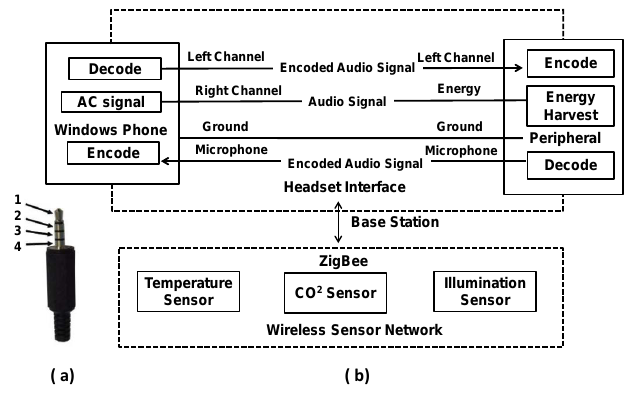
Figure 4: (a): The headset plug and pinout: (1) left earphone (tip), (2) right earphone (ring), (3) common/ground (ring), (4) microphone (sleev e). (b): The structure of Hijack system. It is a big challeng e to obtain energy from the headset port and convert it with high conversion e ffi ciency [19]. The headset outputs a low voltage signal, which is even lower than the typical transistor’ s threshol d voltage. So it is necessary to use energy harv esting circuit to convert it to a higher voltage signal. In Hijack, the energy harv esting circuit consists of a step- up micro- transf ormer, a FET-based rectific tion, some (par allel) blocking Schottky diodes and some fi ter capacitors [20]. The key design, the micro- transf ormer, lev erages a recen tly introd uced device for f y backing and step-up in energy harv esting applica tions. With this design, the energy harv ester can suppl y 7.4 mW voltage and the transf er scheme o ff ers 8.82 kb bandwid th, which satisfie the interf ace in iPhone. The other engineering challeng e is to provide bi- directional comm unica tion betw een the mobile phone and the microcon troller [21]. To achiev e this goal, the microcon troller needs to implemen t both the modula tor function and the demod ula tor function. The Hijack uses the well-established Bell 202 signaling technique at a lower data rate of 0.3 kbps. At the digital lev el, the Hijack uses low-voltage RS-232 signaling to gener ate a virtual univ ersal asynchronous receiv er/tr ansmitter (UART) abstr action over the audio serial bit